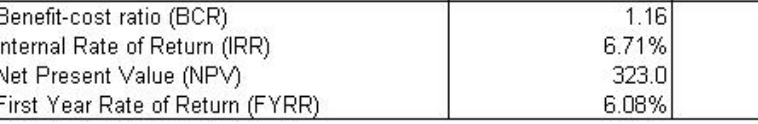
Figure 7. Aggregated rates of return (Salling 2008)